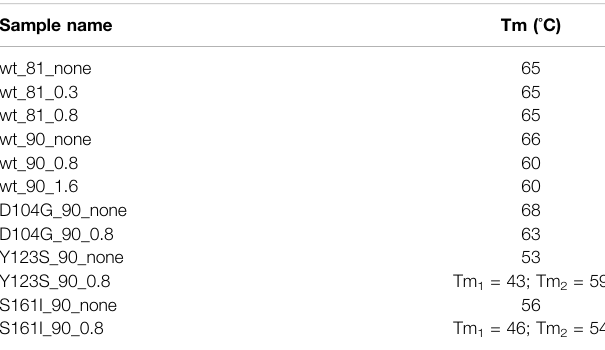
TABLE 2 | Melting temperature of wt-FXN and D104G, Y123S, and S161I variants,intheabsenceofCo 2+ andinthepresenceof0.8and1.6Co 2+ equiv. Sample names are as shown in Table 1